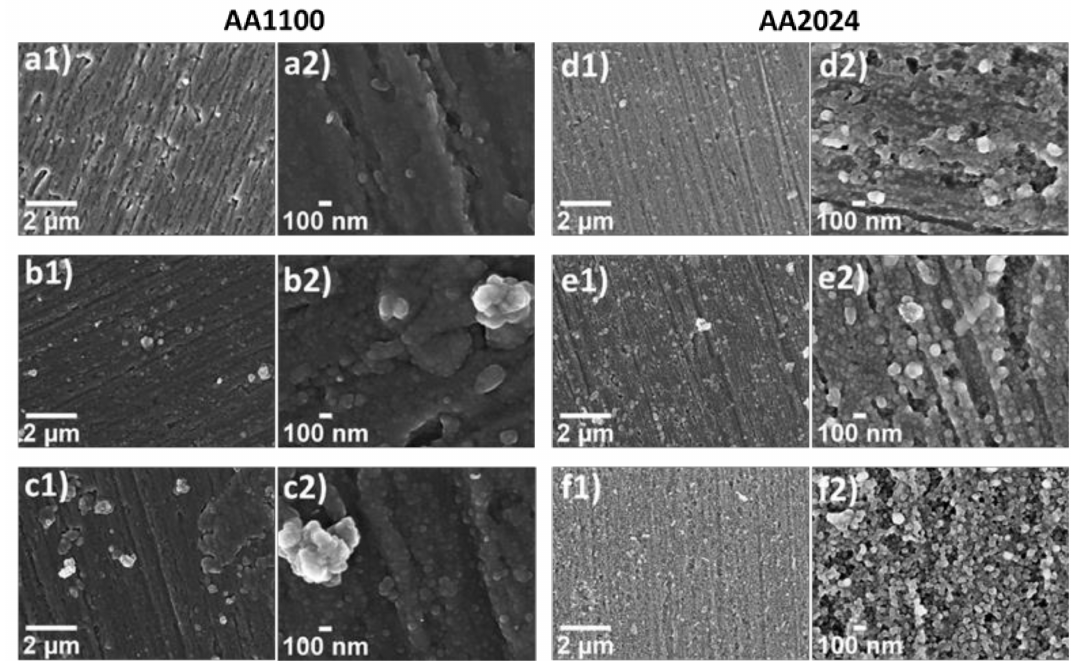
Figure 5. SEM micrographs at low (1, 30 kX) and high magnifications (2, 150 kX), evidencing the morphology of zirconium oxide in the following samples: ( a ) Zr-DC/AA1100; ( b ) Zr-EAD − 1.0V/AA1100; ( c ) Zr-EAD − 1.5 V/AA1100; ( d ) Zr- DC/AA2024; ( e ) Zr-EAD − 1.0 V/AA2024; and ( f ) Zr-EAD − 1.5